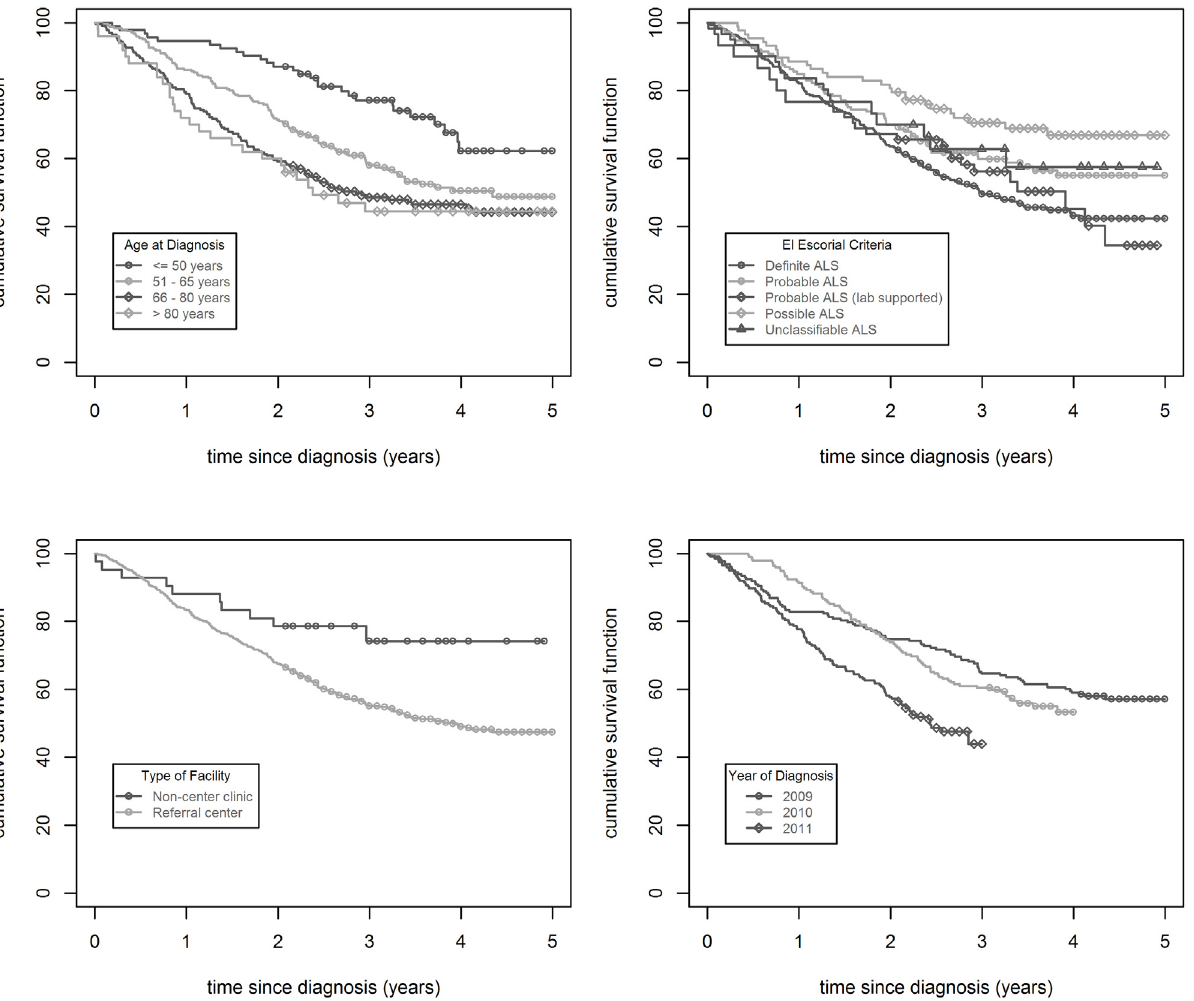
Fig 1. Survival Curves of Selected California County ALS Cases Post-Diagnosis, 2009 – 2013. Kaplan Meier estimate survival curves of ALS cases post-diagnosis from Los Angeles County and selected San Francisco Bay Area counties, by age at diagnosis, last assigned El Escorial criteria, whether seen at referral center and year of diagnosis (diagnosed 2009 – 2011, deceased 2009 –